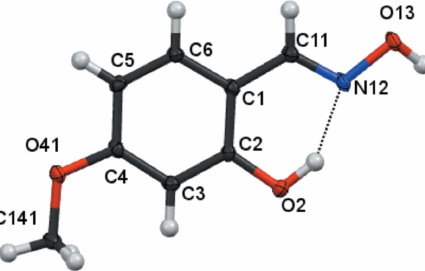
Figure 1 The molecular structure of compound 1 , showing 80% displacement ellipsoids.